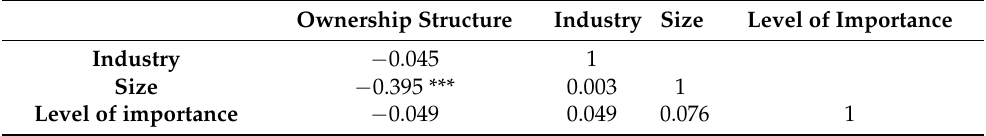
Table 2. Correlations among the regression’s independent variables (ownership structure, industry, size and level of